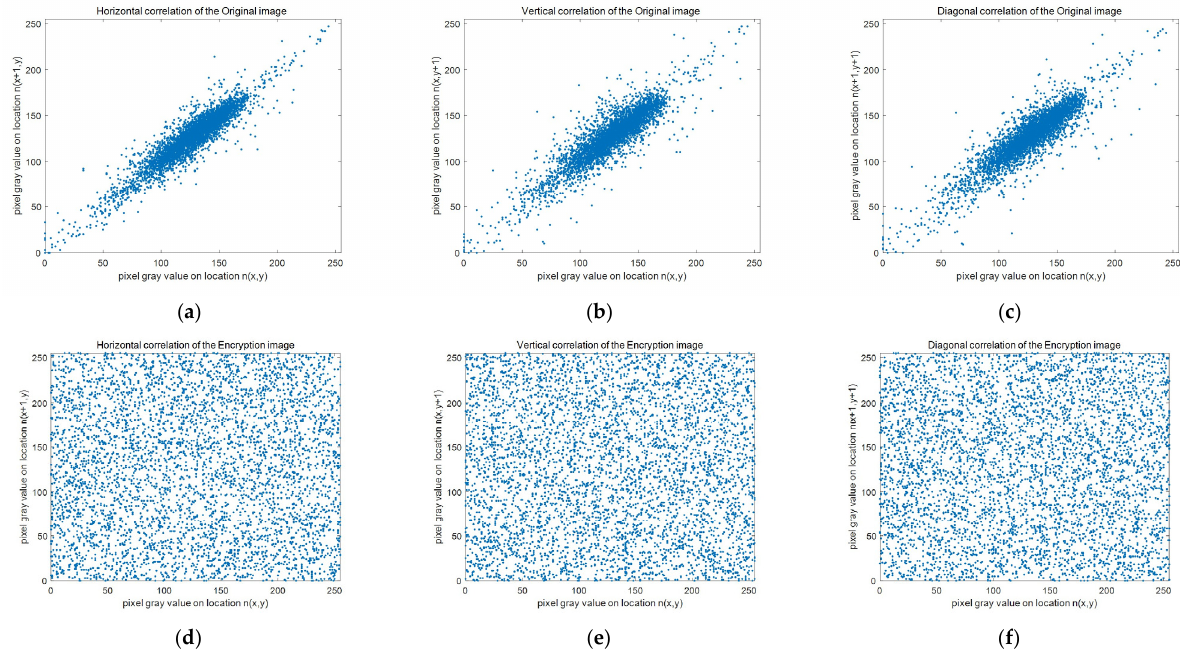
Figure 14. Adjacent pixel correlation of image 5.1.09: ( a – c ) original image; ( d – f ) encrypted image.